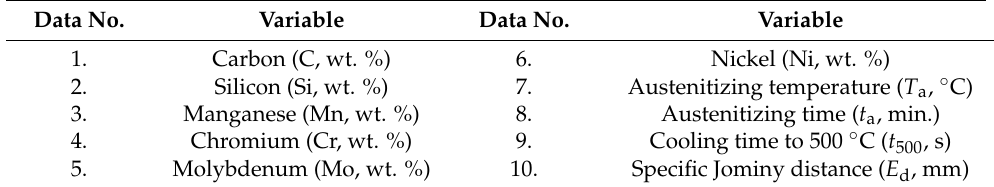
Table 2. The input variables.